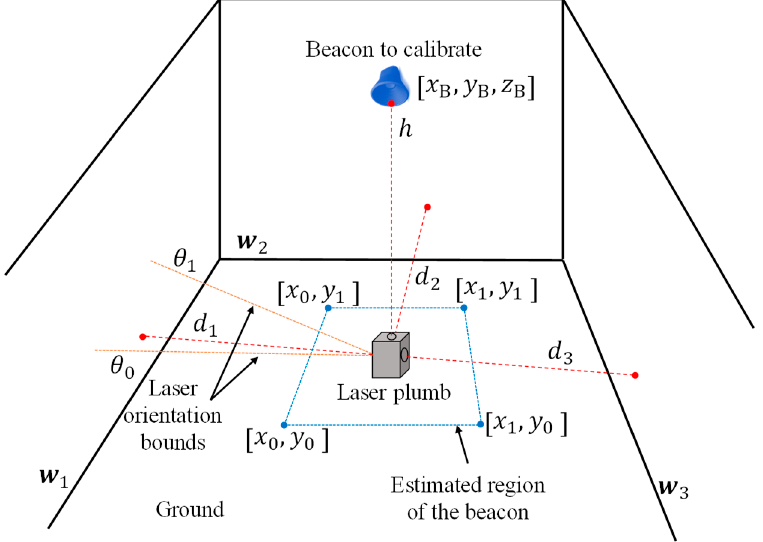
Figure 2. General diagram for the statement of the problem.